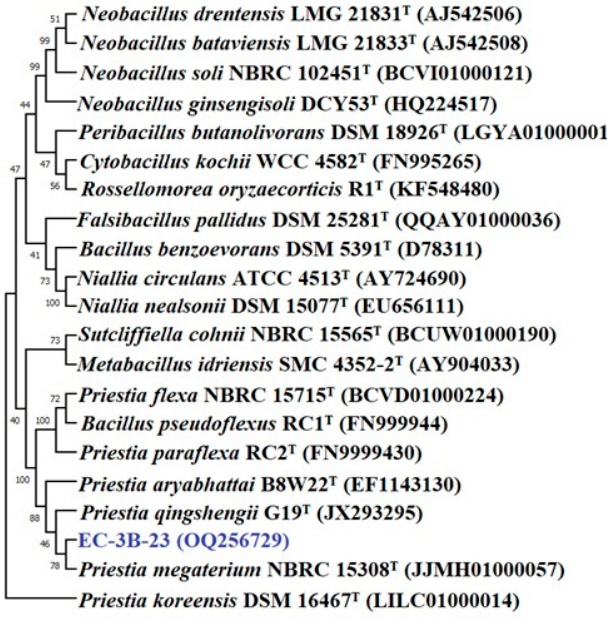
Figure 3. Phylogenetic tree of isolate Pseudomonas sp. EC3B-22 obtained by maximum likelihood method based on the Kimura two-parameter model.